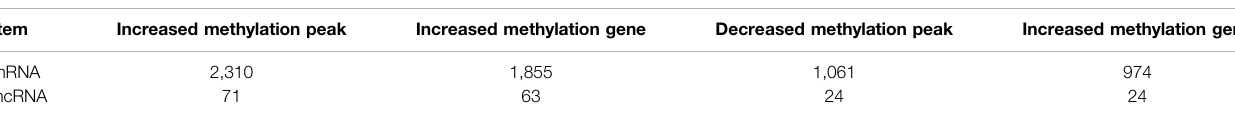
TABLE 4 | General numbers of differentially methylated peaks and genes.